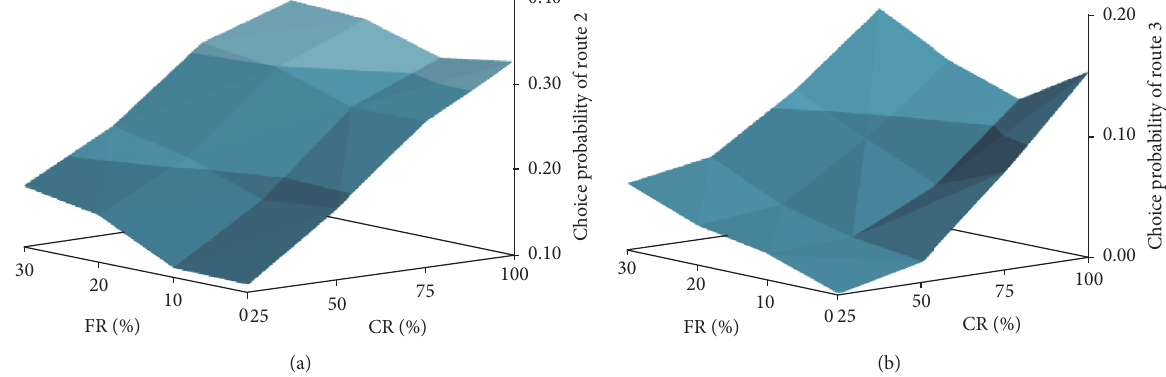
Figure 6: Influence of different FR and CR values on route choice probability of routes 2 and 3.